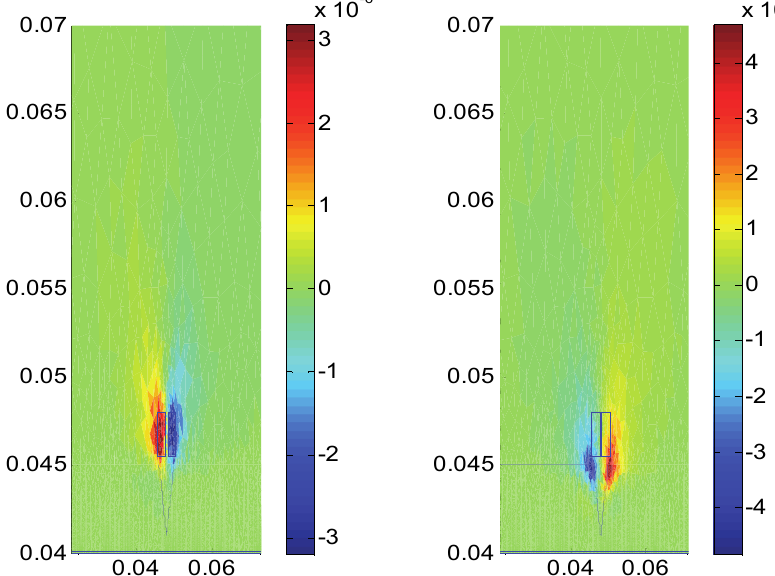
Figure 5: Representation of the real and imaginary part of the